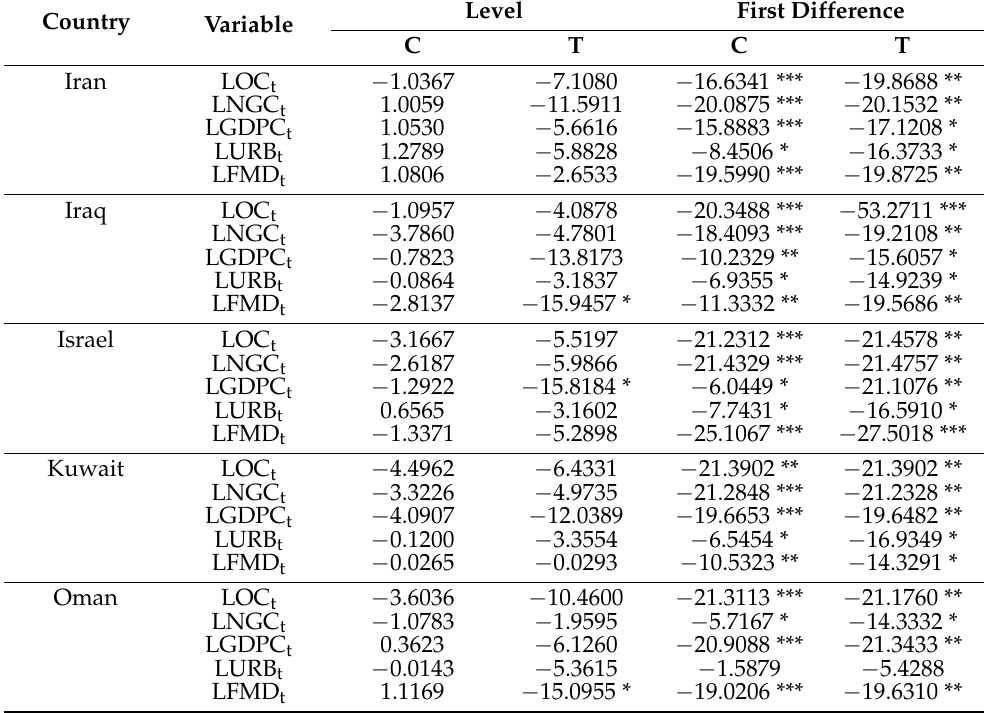
Table A5. Ng–Perron